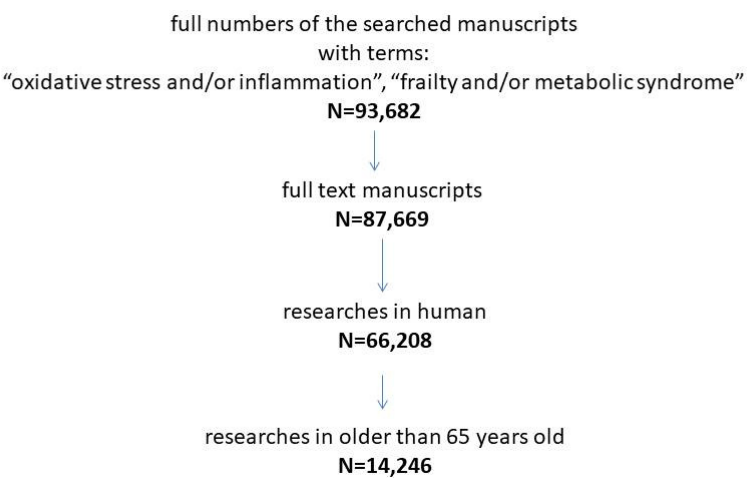
Figure 1. The flow chart describes the search strategy of the Figure 1. The fl ow chart describes the search strategy of the articles.